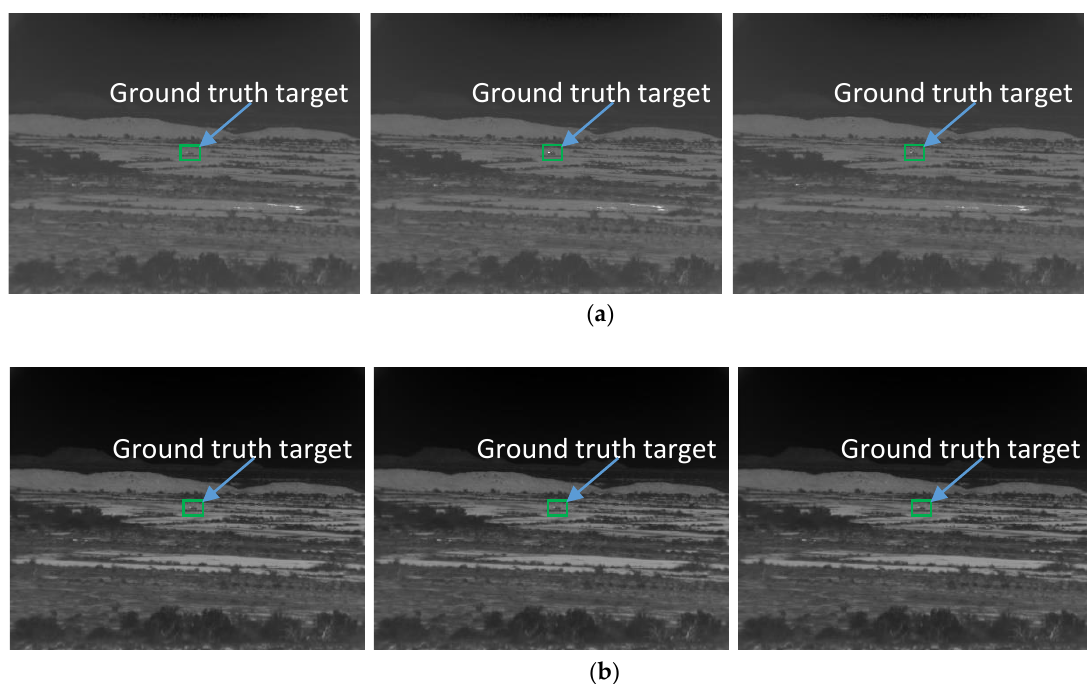
Figure A7. Three Frames from 3500 m for Approach 1 and 3a. ( a ) Approach 1; ( b ) Approach 3a.